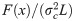
(a) Comparison of the exact probability of survival, ρ(L), given by Eq (17), with the approximations given by the scaling law Eq (22) and by the scaling law with the first correction to scaling, Eq (40), for different m and L. (b) The same taking the y–axis logarithmic. (c) The same data, taking the ratio between the approximation given by the scaling law [F(x)/(σc2L)], Eq (22), and the exact value of ρ(L). Larger values of L are included in this case. The program used to draw the figure is provided as S1 File.